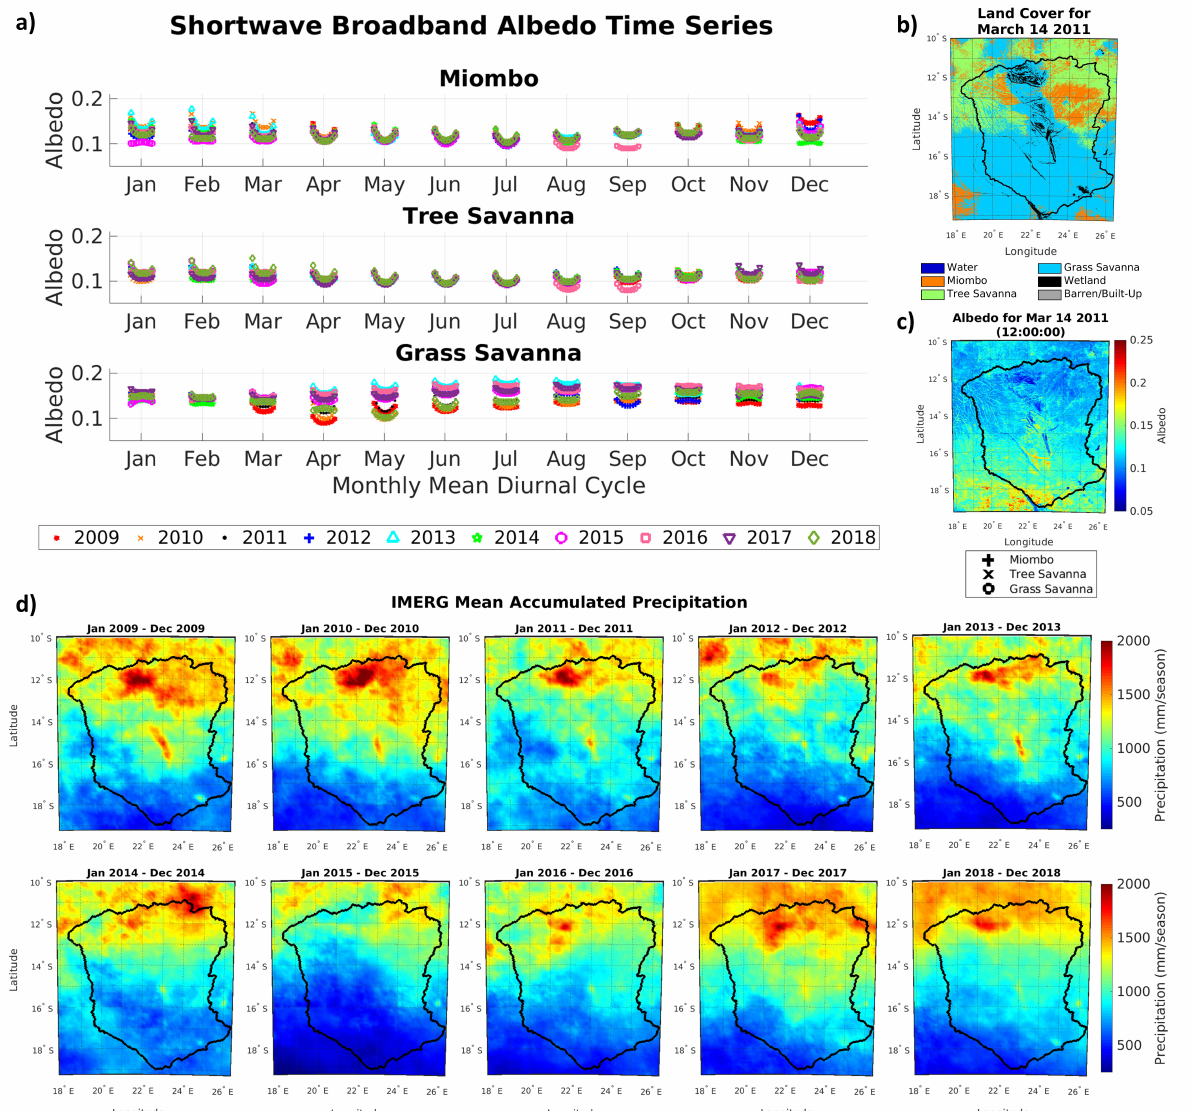
Figure 14. ( a ) Time series comparison of 2009–2018 monthly average diurnal cycles of shortwave broadband albedo for three different land cover types. The 2011 rainy season ( b ) land cover and ( c ) shortwave broadband examples with the miombo (plus sign), tree savanna (cross), and grass savanna (circle) pixels corresponding to the time series marked spatially with black symbols. ( d ) IMERG precipitation data for each calendar year between 2009 and